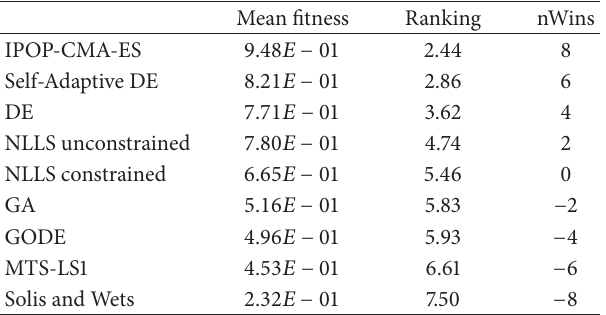
Table 20: Mean fitness, average ranking, and number of wins (nWins) in pair-wise comparisons with the other algorithms for all the models.